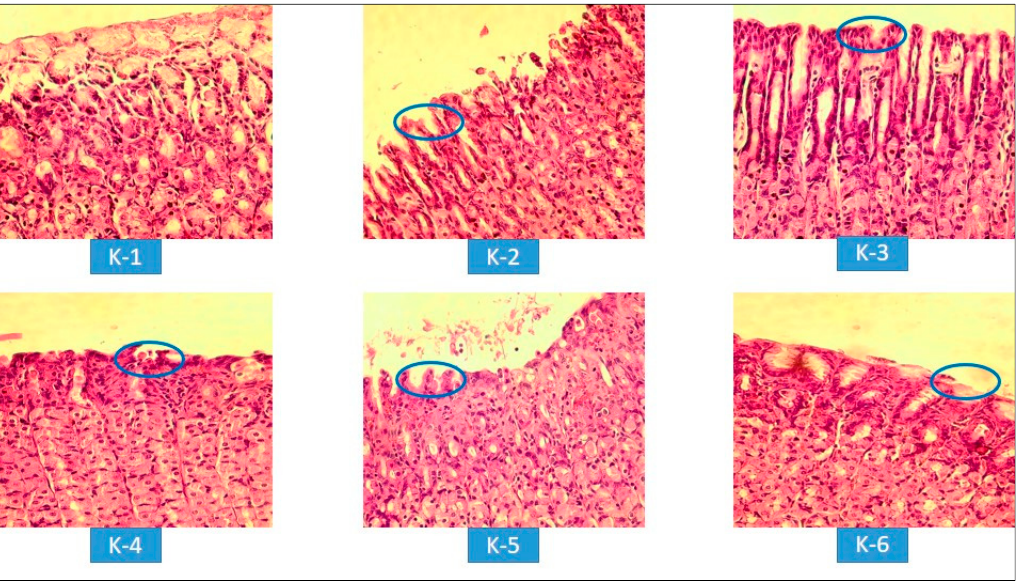
Figure 3. Microscopic result of epithelial erosion on mucosal layers of treatment group: K-1, Normal group; K-2, Negative control group (CMC); K-3, Positive control group (OMZ); K-4, Rice Bran Extract group 100 mg/kg BW; K-5, Rice Bran Extract group 200 mg/kg BW; and K-6, Rice Bran Extract group 400 mg/kg BW) (magnification 400 × ). = Epithelial erosion of mucosal layers.